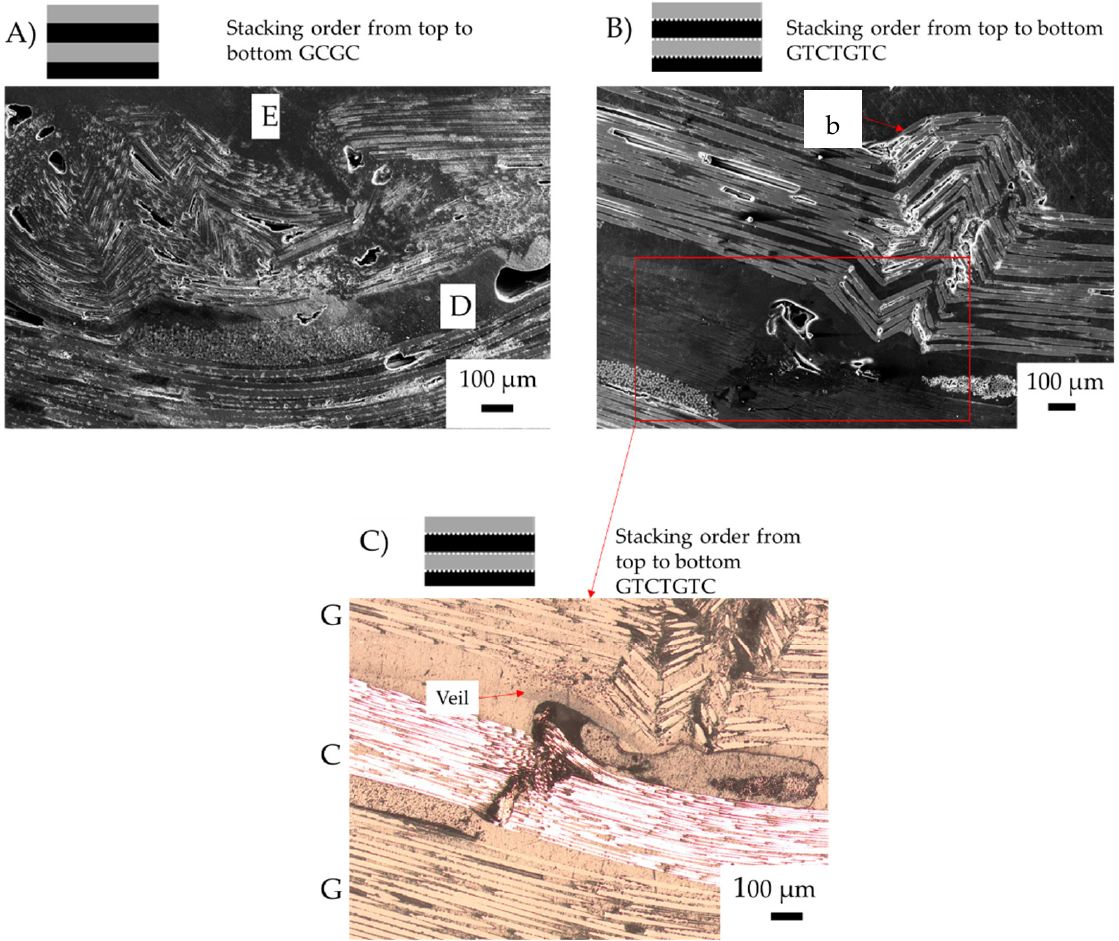
Figure 20. Post-failure micrographs of carbon/glass hybrid fibre failure mechanisms after three-point bending ( A ) GCGC; ( B ) GTCTGTC, failure mechanism of toughened structures with glass fibre under compression; ( C ) optical micrograph of veil trapping crack propagation in GTCTGTC notated by area D. Annotation: E (elastic buckling), b (fibre buckling) and D (delamination). Red lines indicate fibre failure, fibre direction shown with red arrow. Where G is the glass fibre ply and C is the carbon fibre ply.